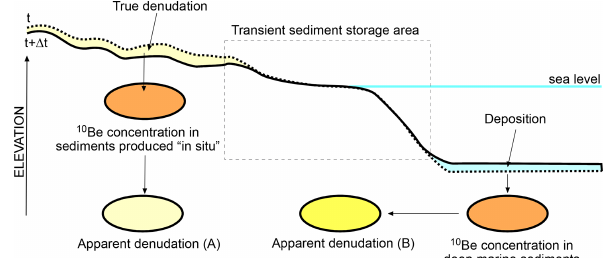
Figure 5. Schematic description of the approach used to compare the apparent denudation for a given time step computed from the mean 10 Be concentration of sediments produced in situ (left part of the topographic profile, apparent denudation A) and from the mean 10 Be concentration of marine sediments ( 10 Be MS ; right part of the profile, apparent denudation B) with the true